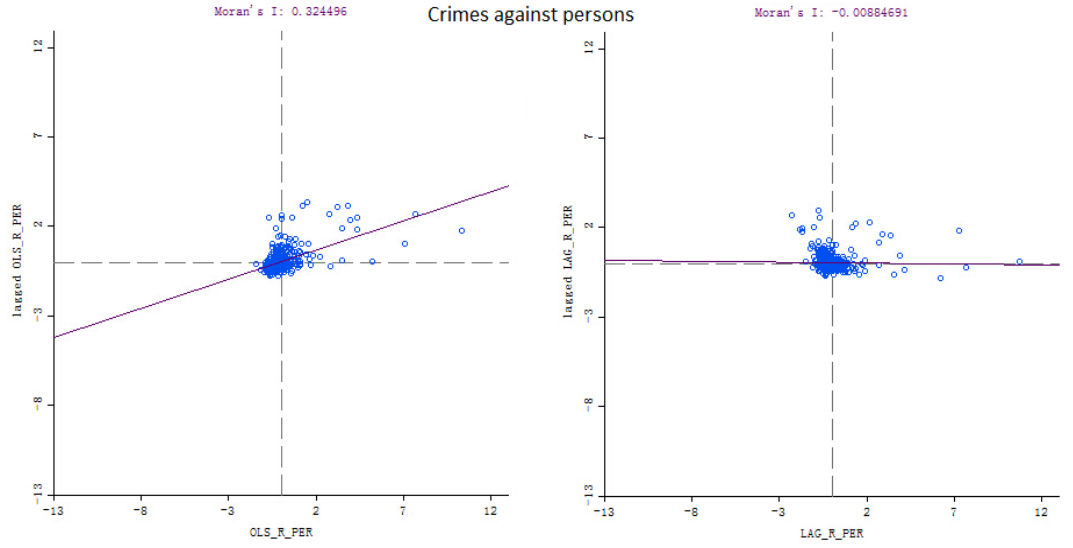
Figure 3. Moran’s I tests for crimes against persons (OLS: left; Spatial lag: right).